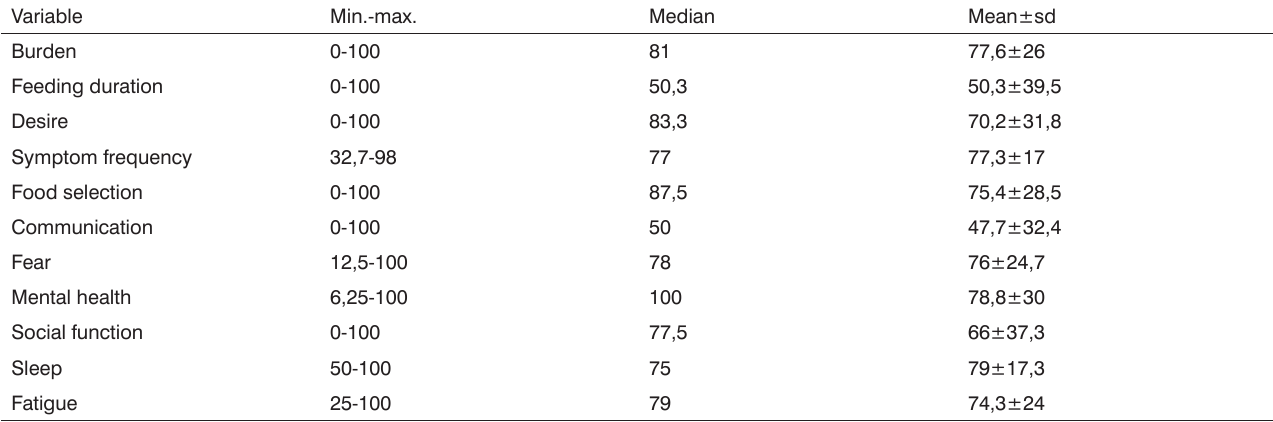
Table 4. Association between the SWAL-QOL and the presence or absence of a diagnosis of dysphagia. (n=28)